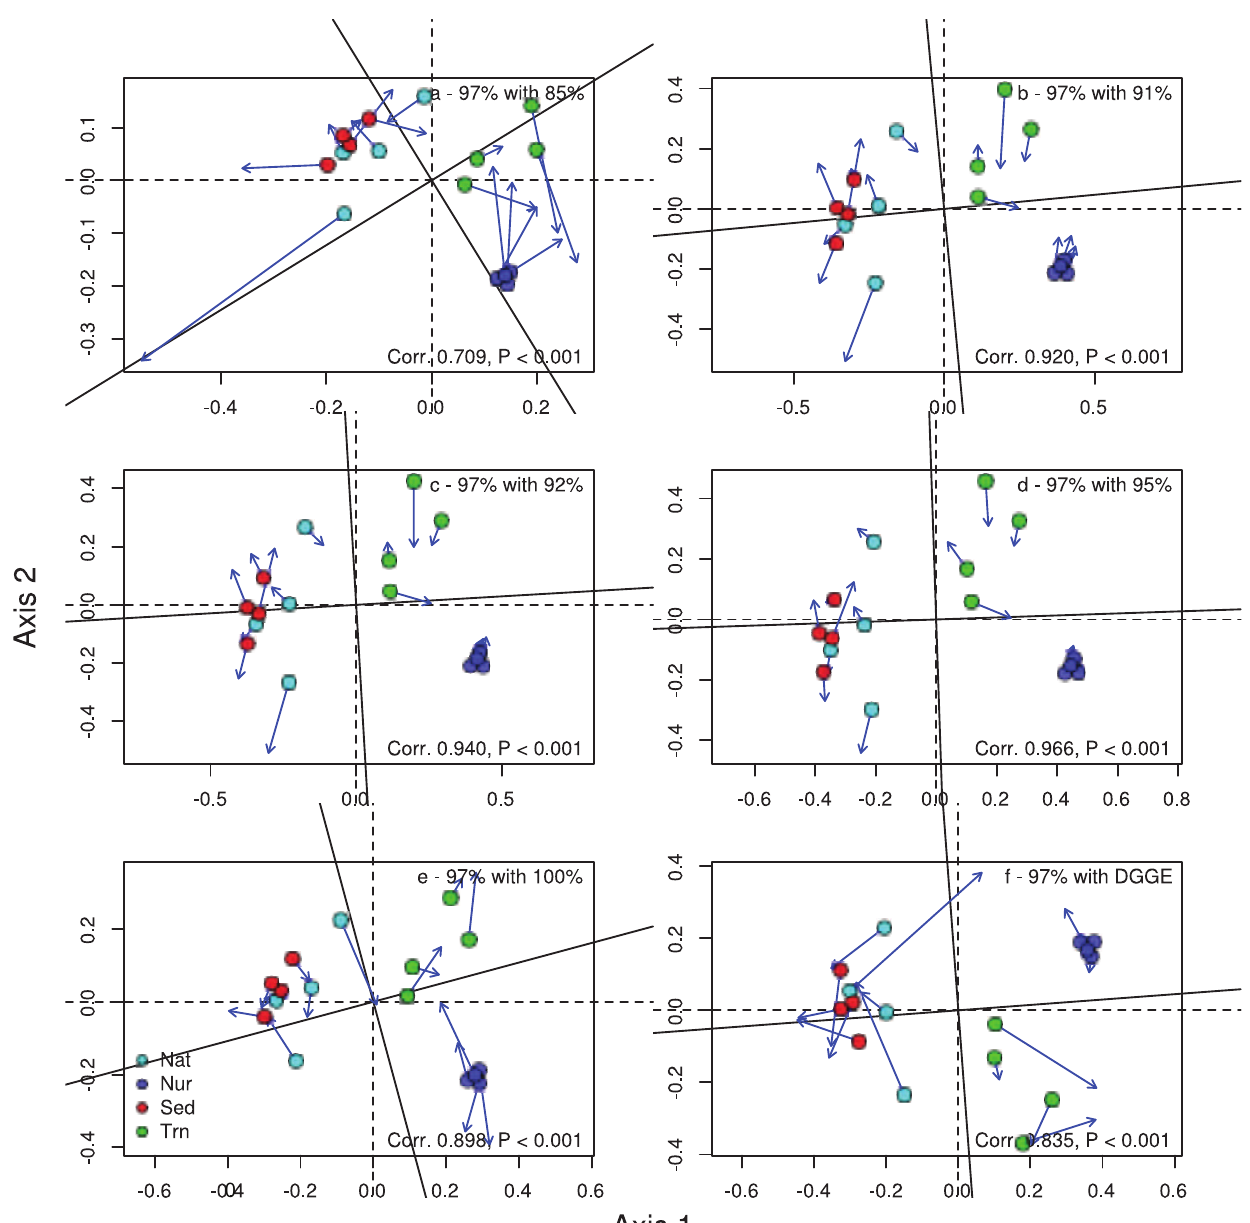
Figure 3. Ordination showing the first two PCO axes of the Betaproteobacteria only analysis for a) 85% cut-off level with 97%, b) 91% cut-off level with 97%, c) 92% cut-off level with 97%, d) 95% cut-off level with 97%, e) 100% cut-off level and f) DGEE data with 97% cut-off level. The arrows in the ordination point to the target configuration, the actual symbols represent the rotated configuration, i.e., the ordination based on the 97% cut-off values. Correlation (Corr) and significance values are given in the lower right corner of each graph.